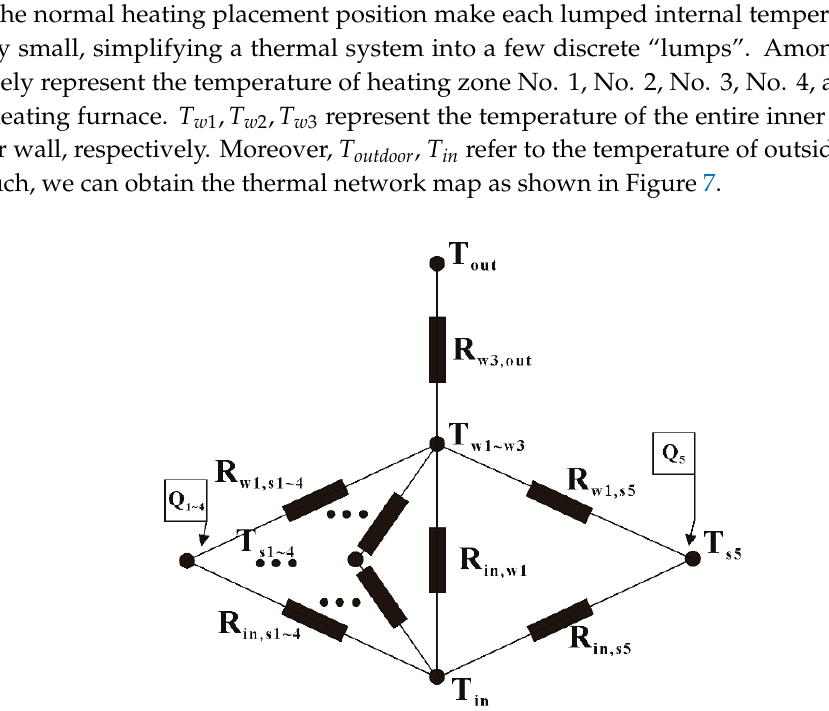
Figure 7. Heat transfer lumped parameter equation of surface observation cabin.